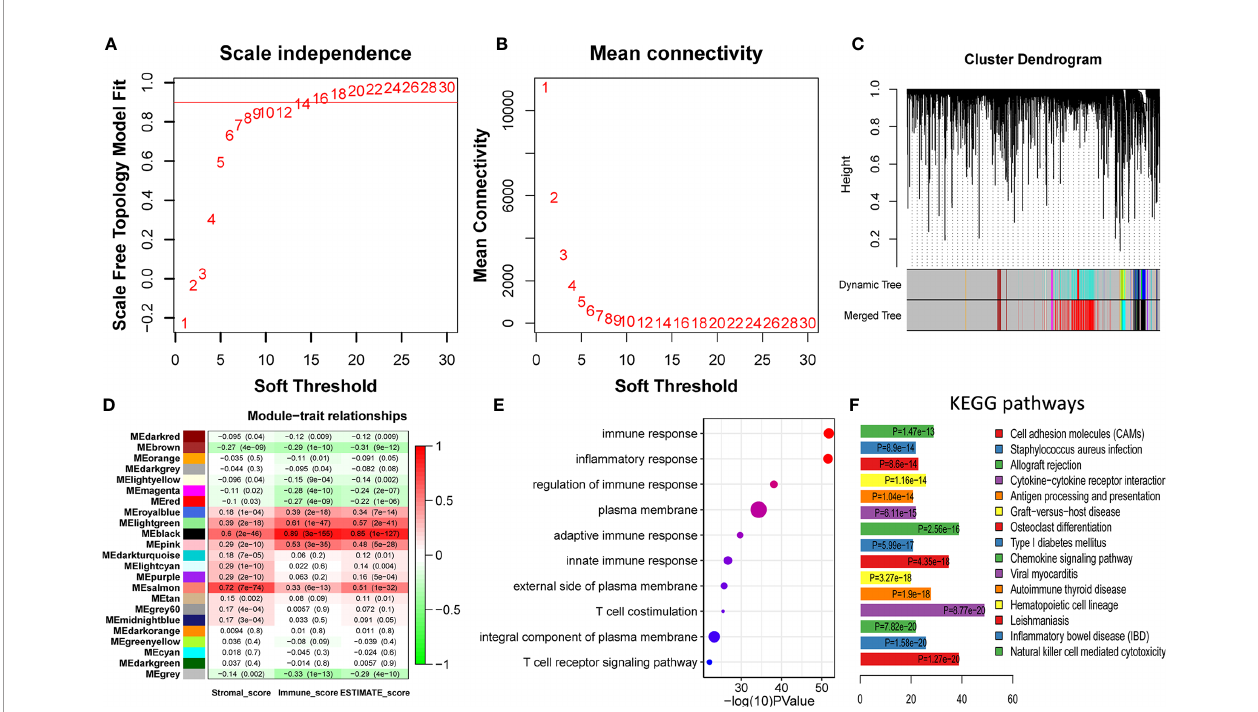
FIGURE 2 | Identi fi cation and validation of immune-related modules (A, B) Analysis of network topology for various soft-thresholding powers. (A) This panel shows the scale-free fi t index as a function of the soft-thresholding power. (B) This panel displays the mean connectivity as a function of the soft-thresholding power. (C) Clustering dendrogram of genes, with dissimilarity based on topological overlap, together with assigned merged module colors and the original module colors. Each color represents a module. (D) Module-trait association. Each row represents a module, and each column represents a trait. Each cell contains the corresponding correlation and P value. Module Black (MEblack) is the most immune score-related ( P = 3e-155, R = 0.89). (E) The top 10 categories are all immune- related in GO enrichment analysis based on genes in Module Black, supporting genes in Module Black are indeed immune-related. (F) Most of the top 15 KEGG pathways are also immune-related, underscoring genes of Module Black are related to